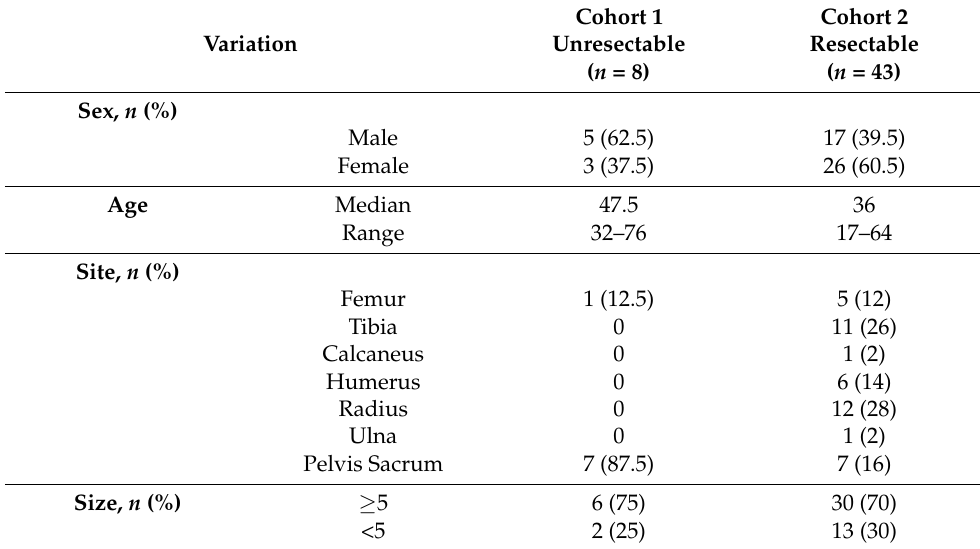
Table 1. Patient characteristics at baseline ( n =